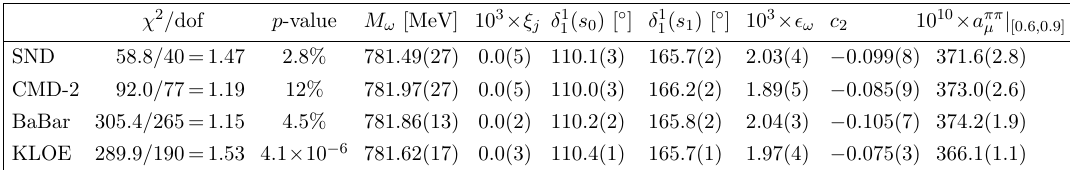
Table 5. The same as table 2, but with both free ! mass and energy rescaling.